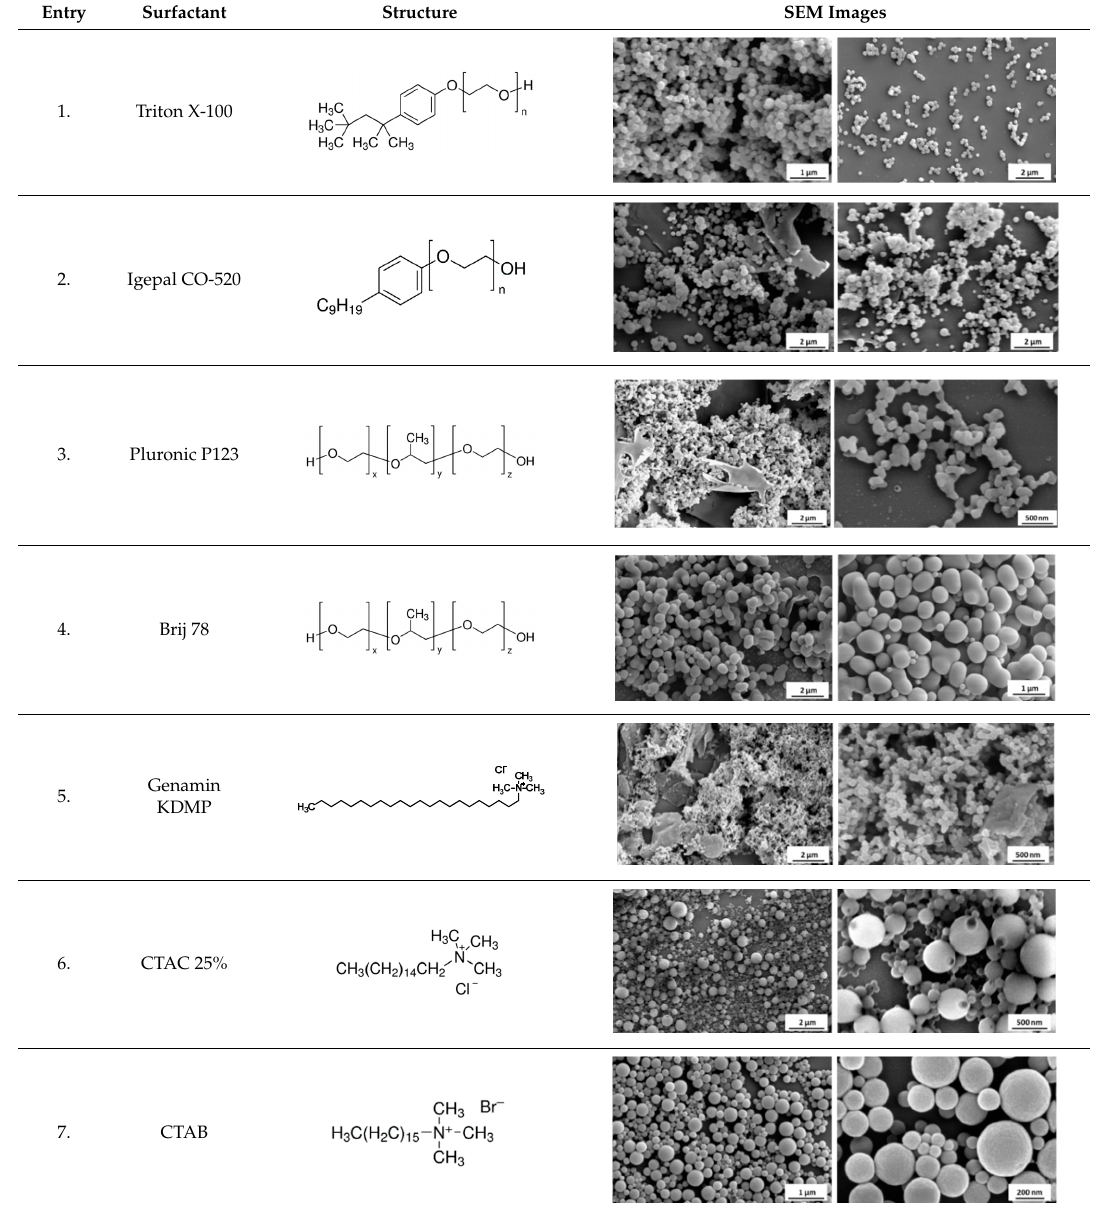
Table 1. Preparation of a chiral PMO system from 1,1 ′ -(( 1R,2R )-1,2-diphenylethane-1,2-diyl)bis(3-(3-